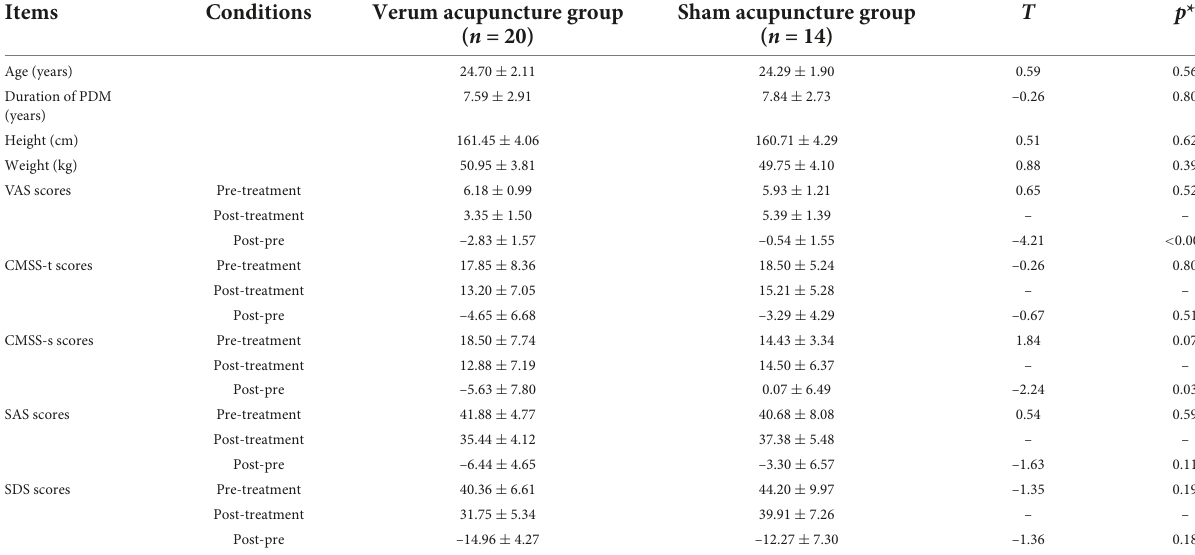
TABLE 1 Demographic and pain assessment of baseline and after treatment.